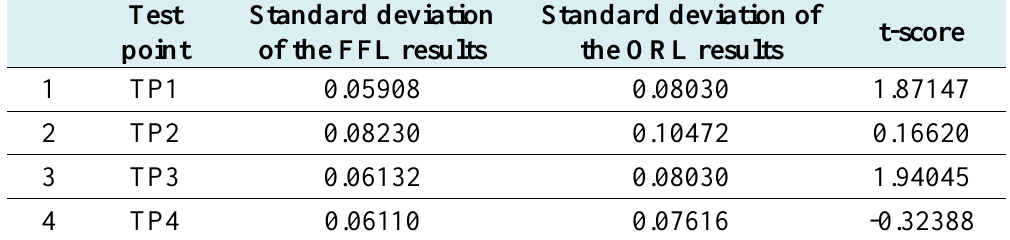
Statistical analysis of FFL and ORL test point